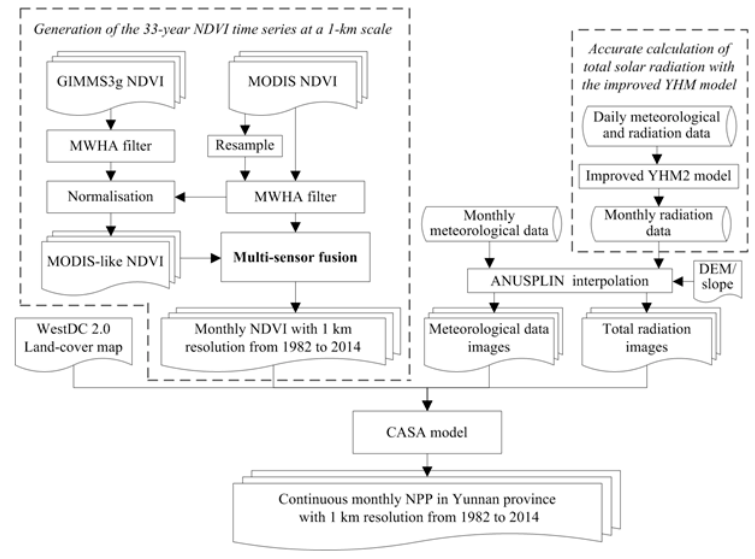
Figure 2. The workflow of NPP estimation.